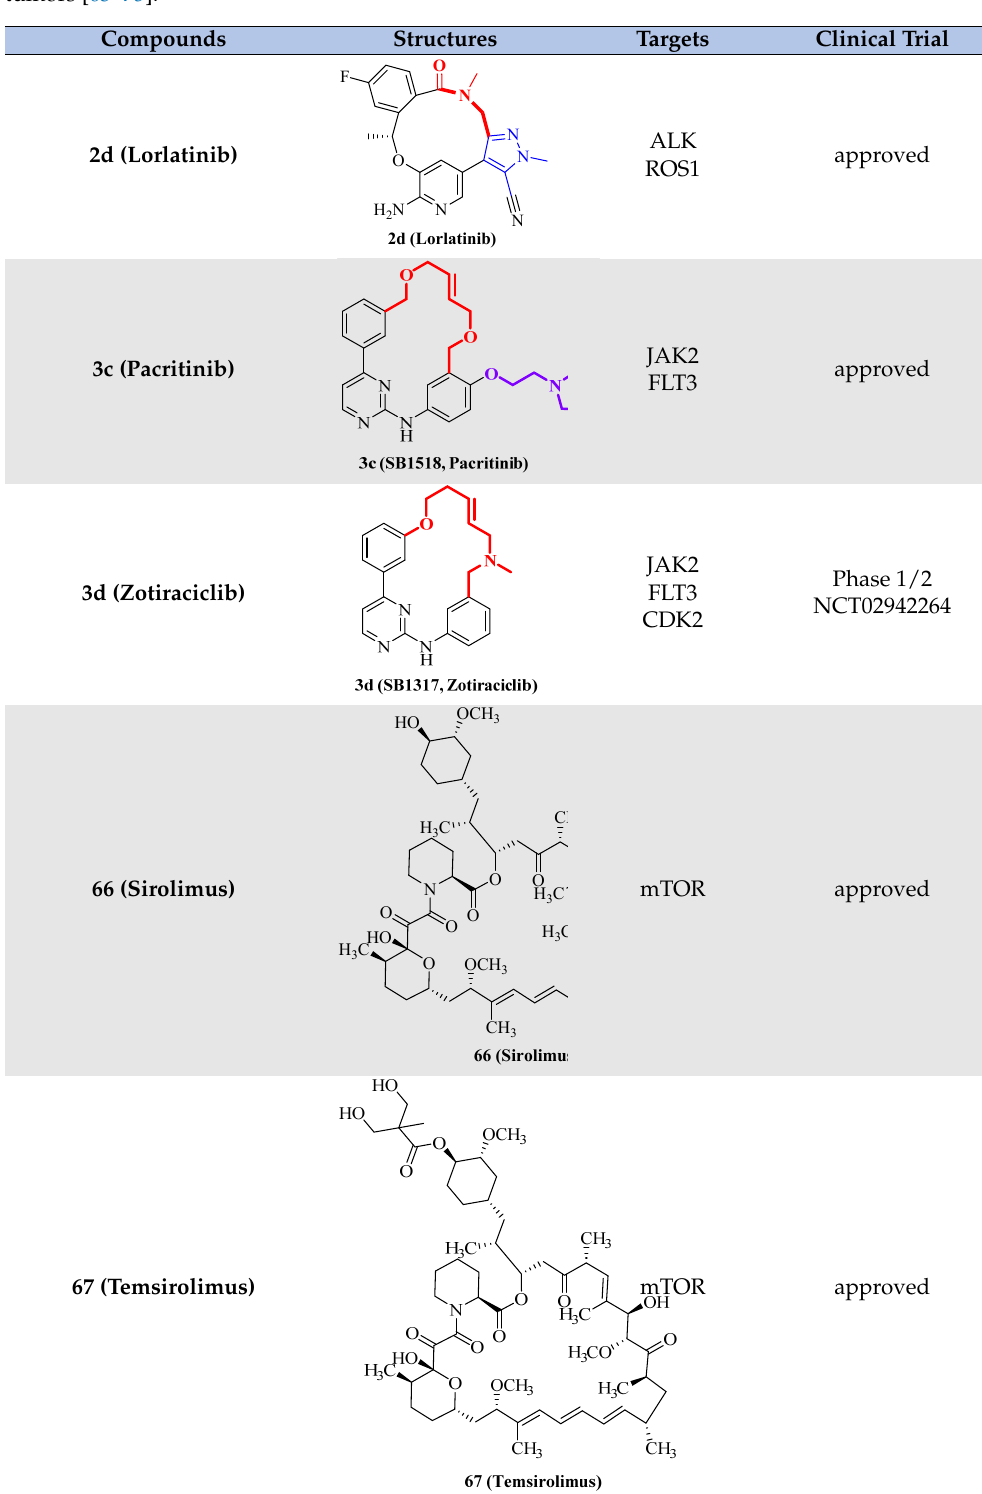
Table 6. Overview of representative macrocyclic compounds for the treatment of malignant tumors [63–75].